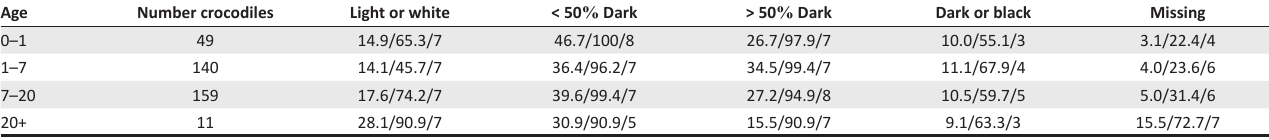
The first number in each colour column is the percentage of the total number of scutes with that colour category in that age group. The second number is the percentage of crocodiles with at least one scute in that colour category. The third number is the maximum number of scutes with that colour in any crocodile in that age